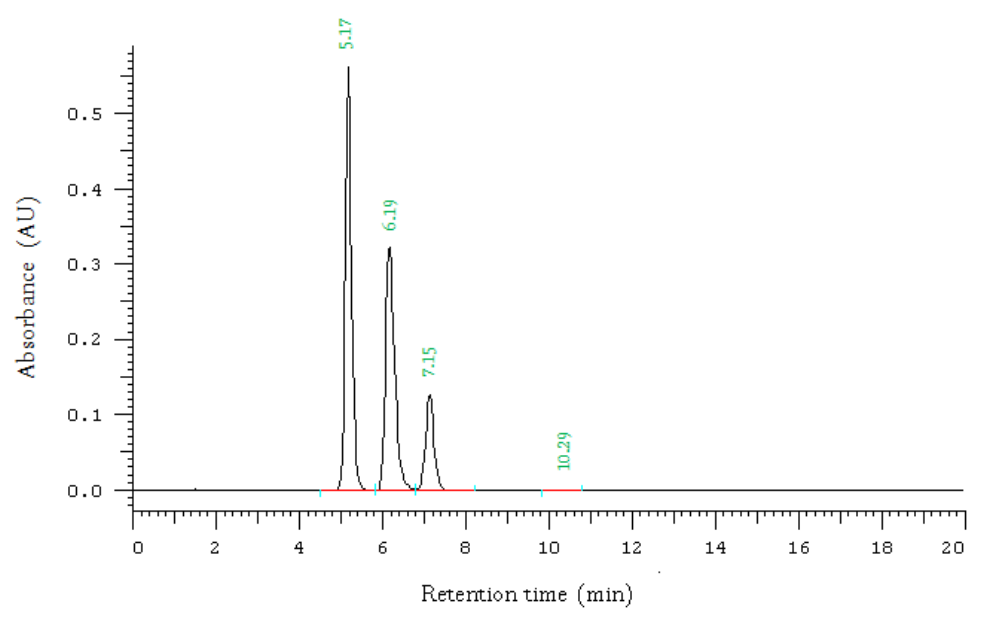
Figure 2. HPLC chromotagram of diclofenac sodium ( 1 ), the N -ethoxycarbonylmorpholine ester prodrug ( 2 ), and 2-hydroxyethyldiclofenac ( 3 ) showing retention times of 5.17 min 6.19 min and 7.15 min,